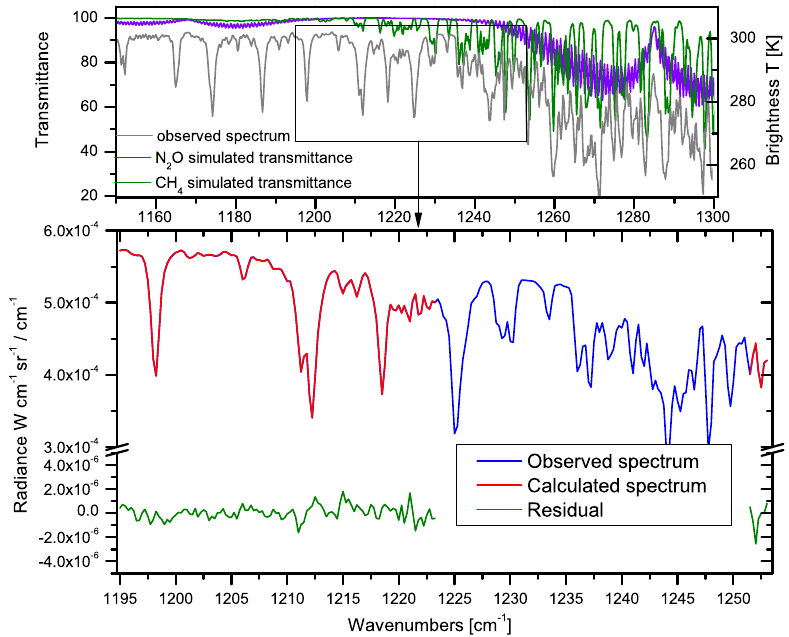
Fig. 1. Spectral window used in the retrieval. Top panel: IASI spectra (black curve) in brigthness temperature with the spectral signature of CH 4 and N 2 O. Bottom panel: example of an IASI observed spectra (blue curve), the calculated spectrum (red curve) and the residual (green curve). The gap between 1223 and 1251cm − 1 avoids major CH 4 and N 2 O